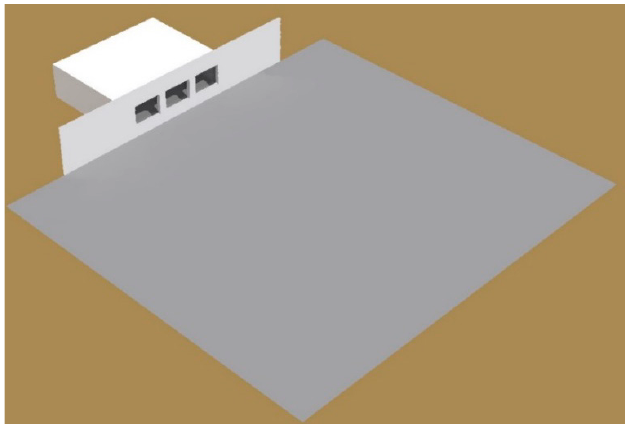
Figure 2. A 12.1 m × 10 m × 3.6 m classroom that is used for general modeling